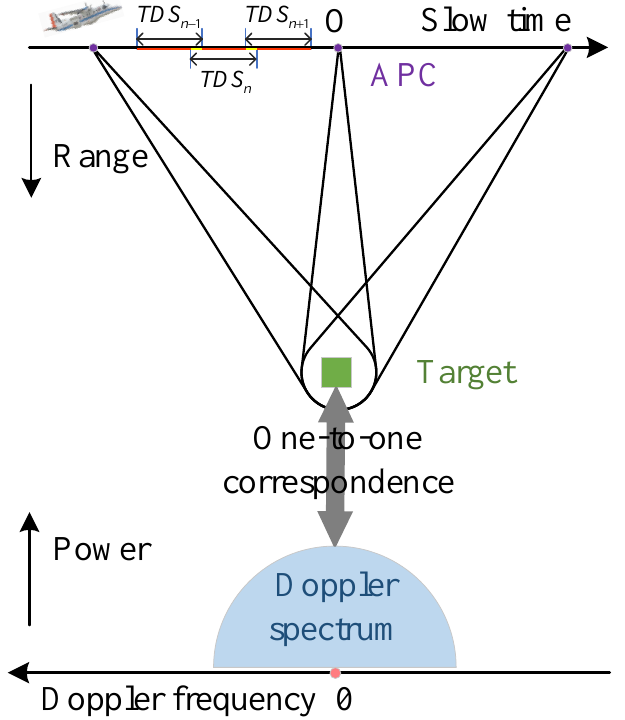
Figure 5. Schematic diagram of the formation of TDS. In addition, it can be seen that there is a one-to-one correspondence between Doppler frequency and beam direction for spotlight mode SAR. “APC” (purple dots) is the antenna phase center of transmission and reception in the slow time domain